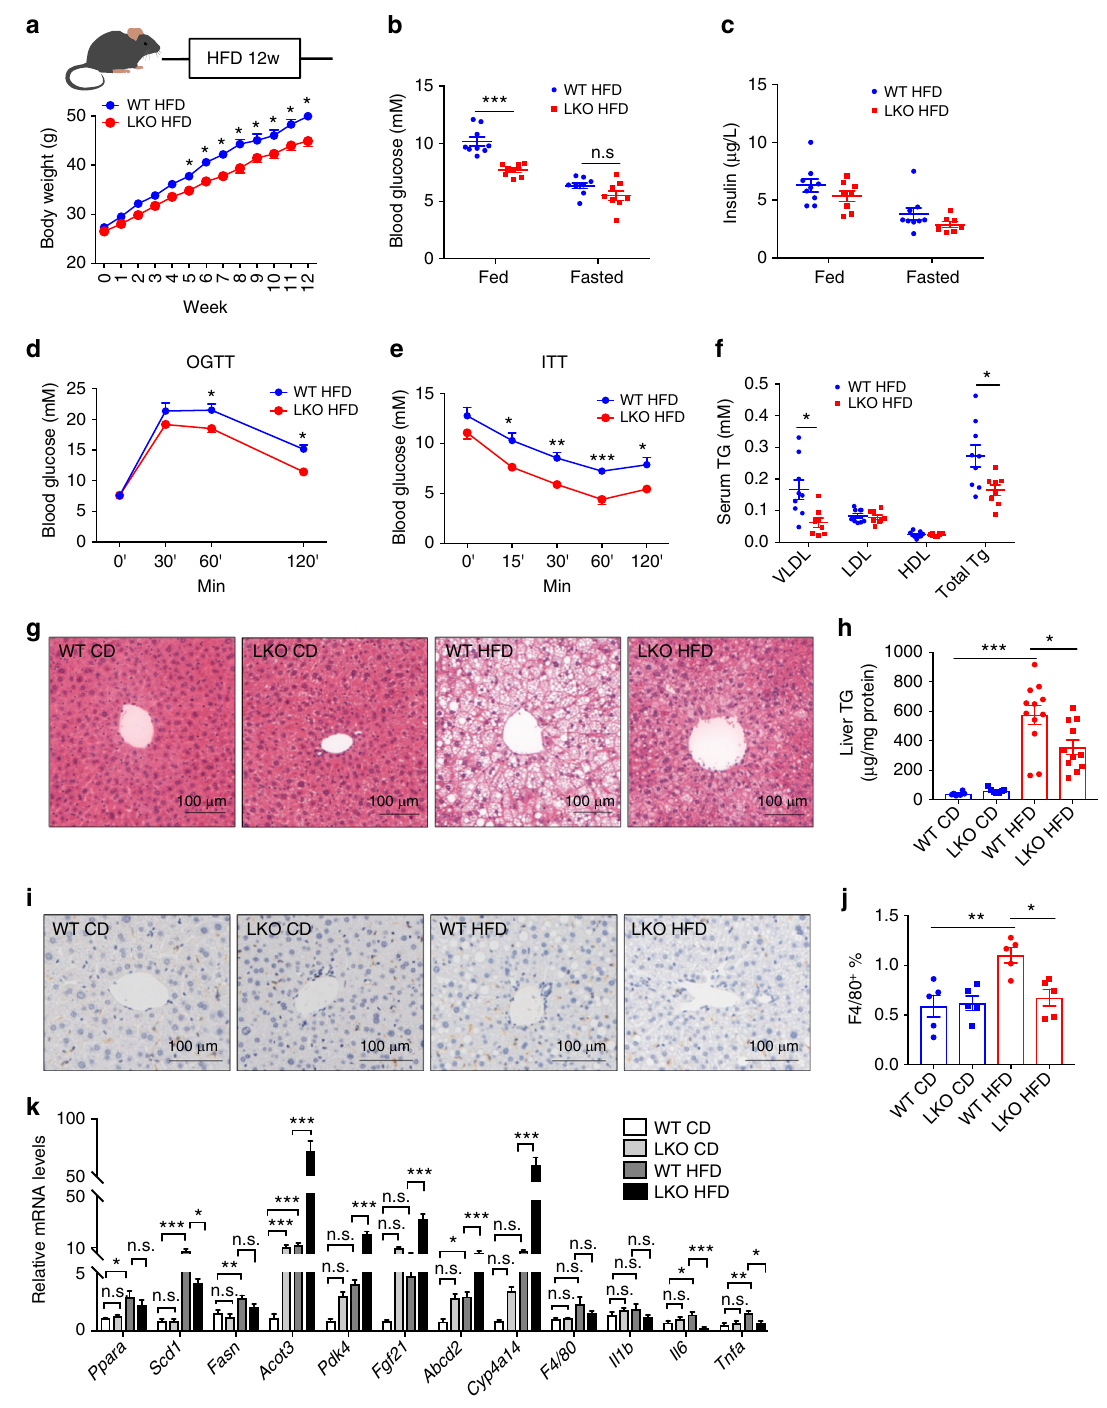
Fig. 2 Gps2 LKO mice are resistant to HFD. a Body weight change during 12 weeks HFD feeding in WT and LKO mice, n = 9 – 16 in WT and n = 10 – 17 in LKO, non-parametric Mann – Whitney test. Fed and fasted ( b ) glucose and ( c ) insulin in WT and LKO mice, n = 9 in WT and n = 8 in LKO, non-parametric Mann – Whitney test. ( d ) OGTT and ( e ) ITT in WT and LKO mice after 12 weeks of HFD, n = 10, non-parametric Mann – Whitney test. ( f ) Triglyceride in VLDL fractions, n = 8 – 9 in each group. non-parametric Mann – Whitney test. ( g ) H&E staining; ( h ) liver triglyceride levels, n = 6 in WT CD, n = 7 in LKO CD, n = 12 in WT HFD and n = 11 in LKO HFD, one-way ANOVA followed by Tukey ’ s test. ( i ) F4/80 staining and ( j ) quanti fi cation, n = 5 in each group. ( k ) QPCR analysis of liver mRNA expressions, n = 5 – 9 in each group from 12 weeks CD-fed or HFD-fed WT and LKO mice, one-way ANOVA followed by Tukey ’ s test. All data are represented as mean ± s.e.m. * P < 0.05, ** P < 0.01, *** P <